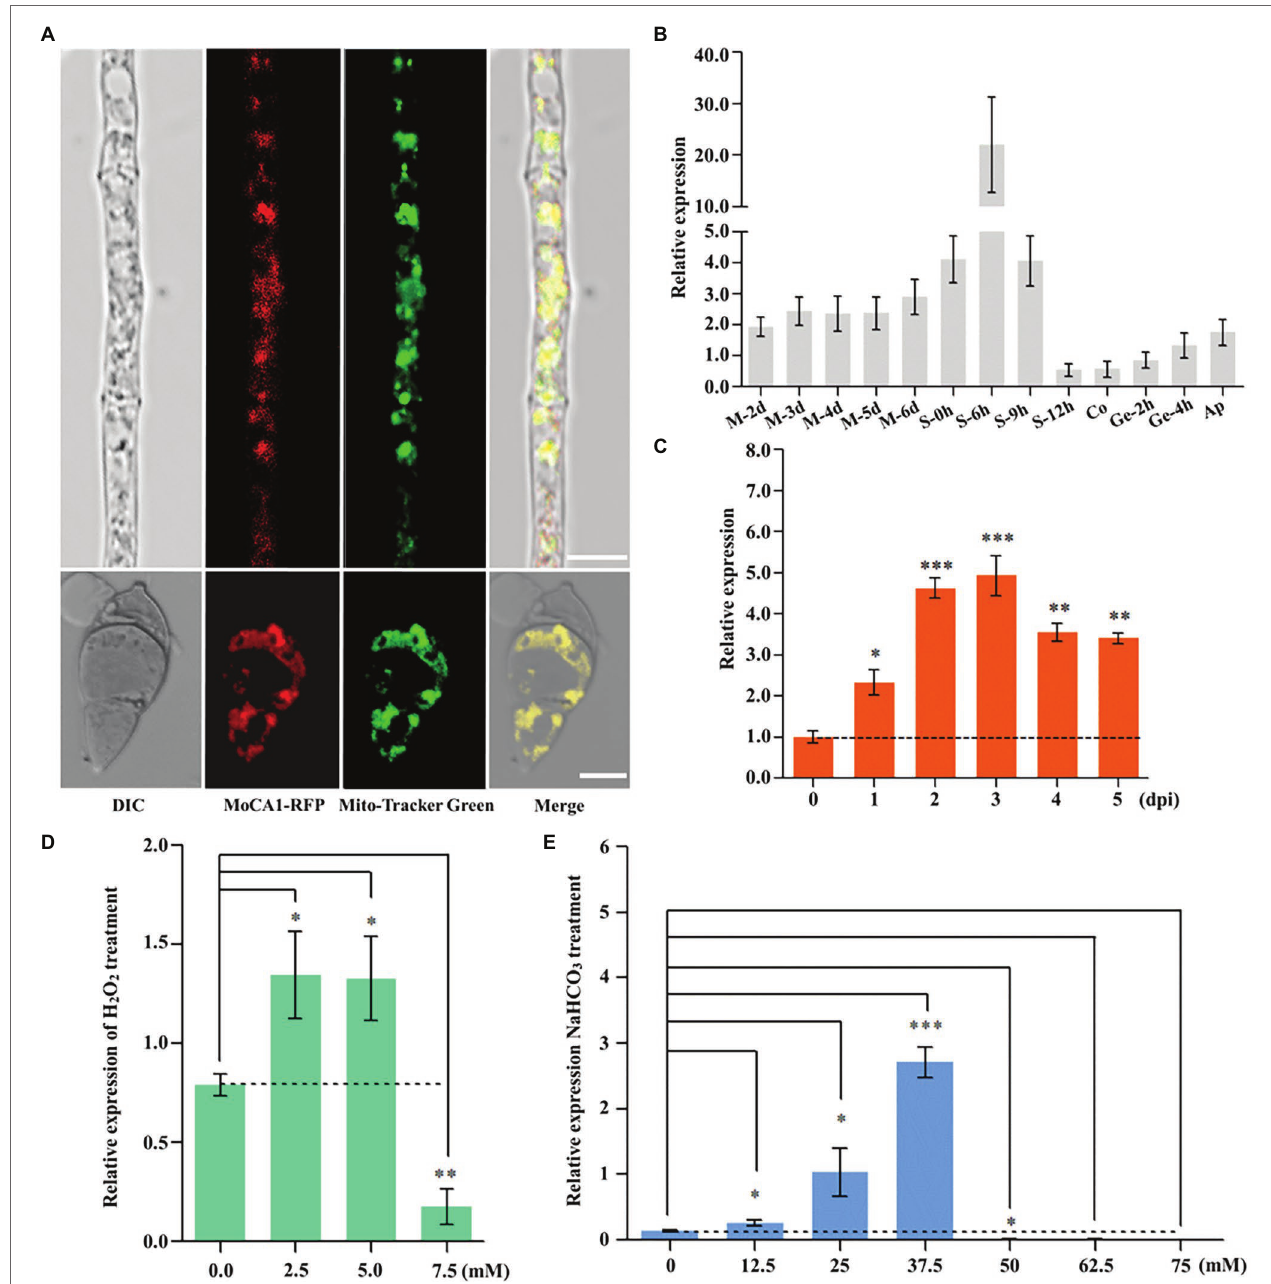
FIGURE 2 | MoAE4 subcellular localization and function in M. oryzae . (A) Subcellular localization in hyphae and conidia (6 days). Red fluorescence signals of the MoCA1-RFP protein of 6-day-old hyphae and conidia were examined by confocal microscopy and co-localized with Mito-Tracker Green on mitochondria. Scale bar = 10 μ m. (B) The expression pattern of growth of M. oryzae . M 0–6 days, mycelia 2–6 days; S 0–12 h, conidiophores 0–12 h; Co, conidia; Ge 2–4 h, germination 2–4 h; Ap, appressoria. (C) The expression pattern of infection development of M. oryzae . dpi, days post-inoculation. (D) Transcription abundance of MoCA1 under different concentrations of H 2 O 2 . (E) Transcription abundance of MoCA1 under different concentrations of NaHCO 3 . Data represent the means ± SD from three independent experiments in which triplicate plates were examined for each strain in each experiment. * p < 0.05; ** p < 0.01; and *** p <